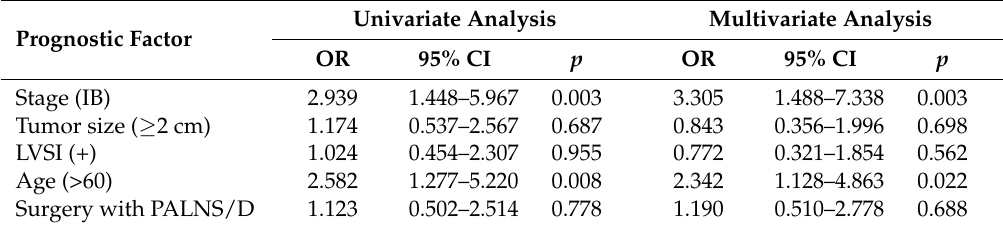
FIGO: International Federation of Gynecology and Obstetrics; TAH: total abdominal hysterectomy; LAVH: laparoscopic-assisted vaginal hysterectomy; BPLND: bilateral pelvic lymph node dissection, PALNS/D: para-aortic lymph node sampling or dissection; LVSI: lymphovascular space invasion; BSO: bilateral salpingo-oophorectomy. Table 2. Univariate and multivariate logistic regression analyses of the prognostic factors for recurrence.